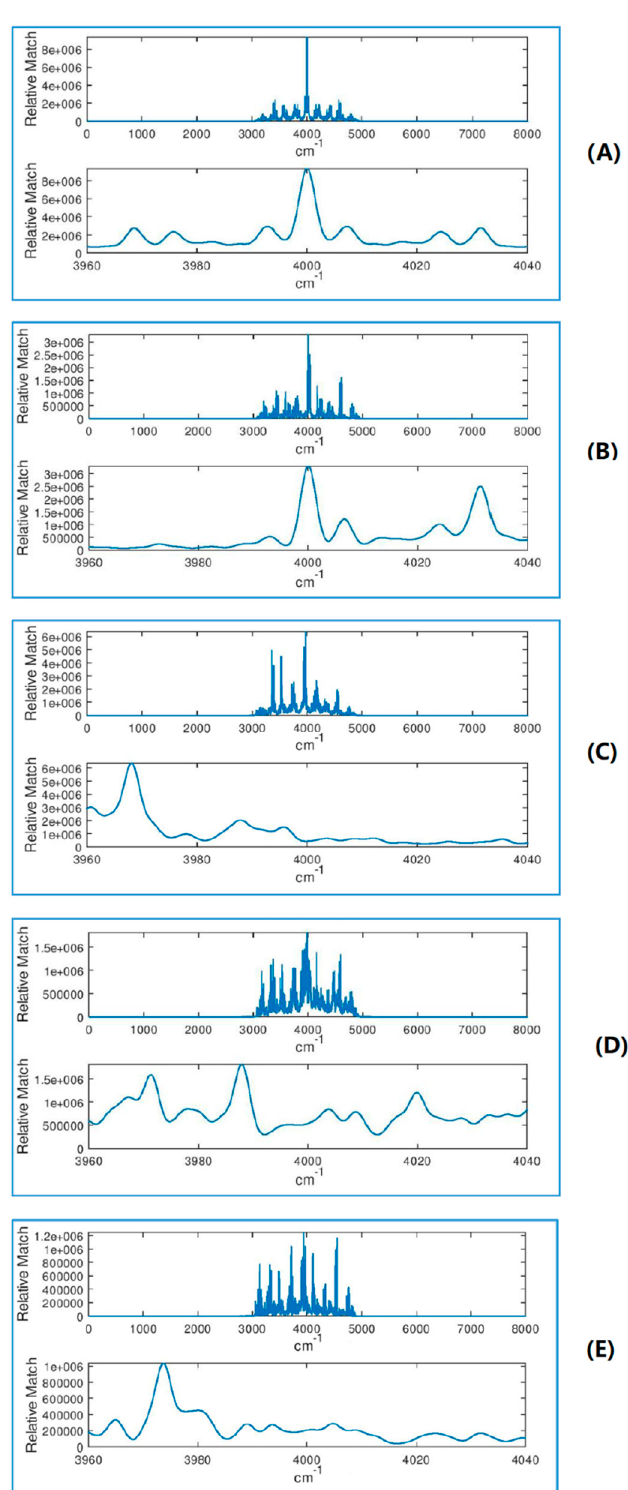
Figure 5. The correlation function of the reference spectrum (anharmonic spectrum computed with B3LYP/6-311G+(2d,2p)) with spectra computed at different levels of theory within a detection window of 680–2000 cm − 1 . From top to bottom: ( A ) B3LYP/anharm/6-311G+(2d,2p) (i.e., autocorrelation), ( B ) B3LYP/harm/6-311G+(2d,2p), ( C ) PBE/anharm/6-311G+(2d,2p), ( D ) B3LYP/anharm/6-31G, and ( E ) PBE/harm/6-31G. The top panel in each pair of plots is for the entire signal y and the bottom panel is zoomed around the center, where a peak is expected.